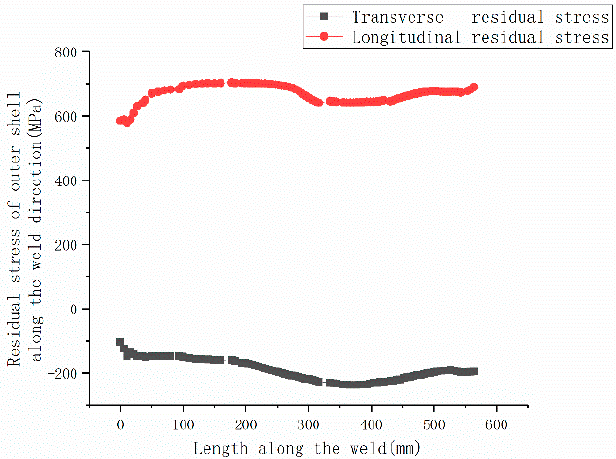
Figure 19. Residual stress along the weld on the outer surface of the spherical pressure hull.